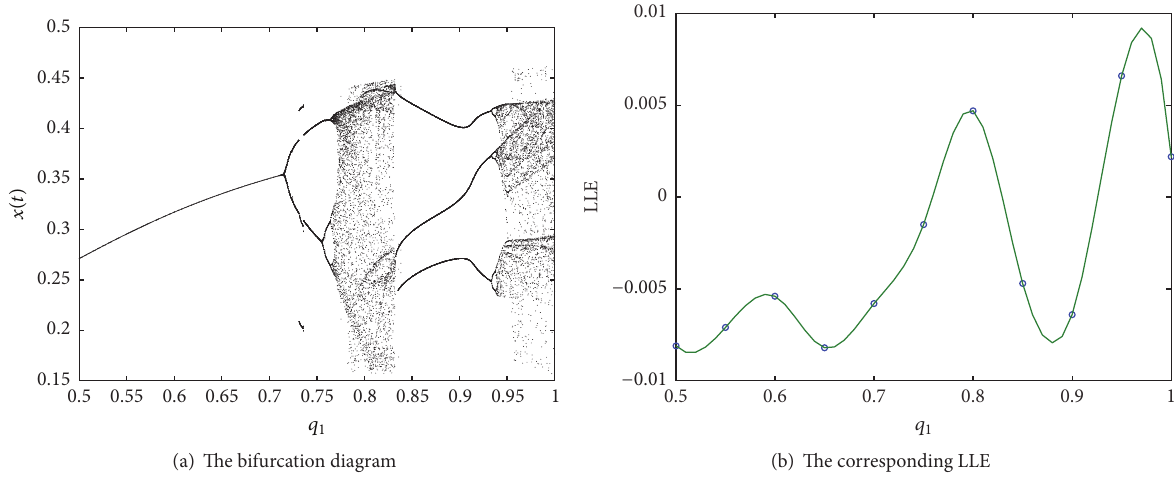
Figure 2: The bifurcation and the corresponding LLE diagrams of system (2) with the order 𝑞 1 ∈ [0.5, 1] .